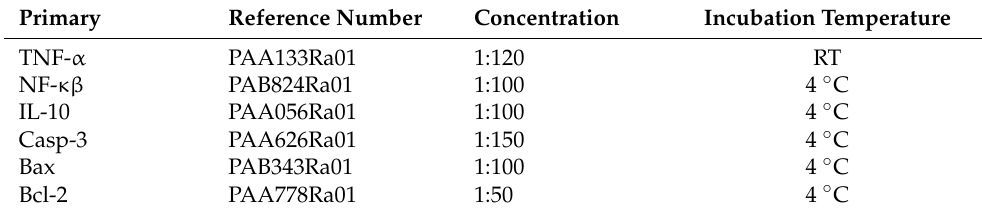
Table 4. Rabbit polyclonal antibodies used in the